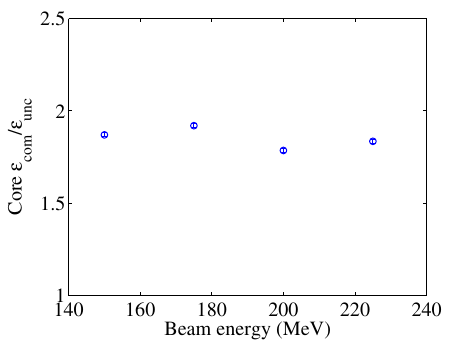
FIG. 4. Measured relative core emittance increase versus the beam energy for a constant compression factor of 5 (dipole bending angle at 4.07°.)